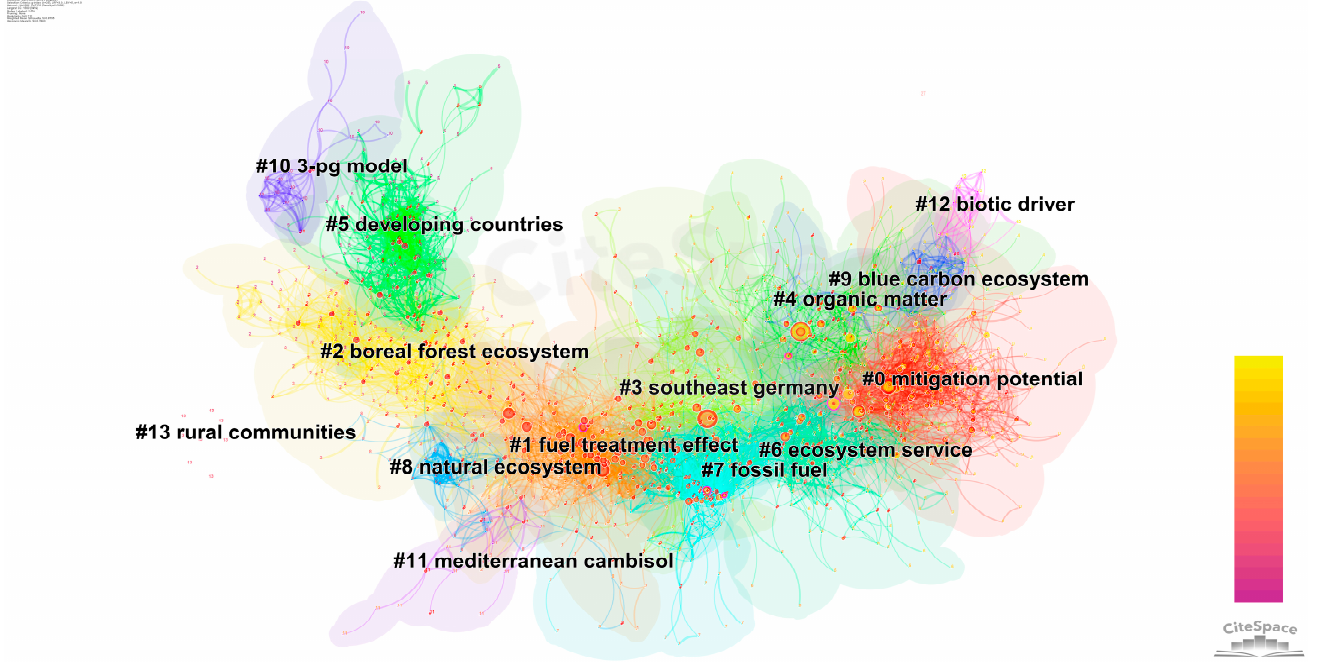
Figure 15. Literature co-citation clustering network mapping. The text starting with # in the figure is the cluster label for that cluster.